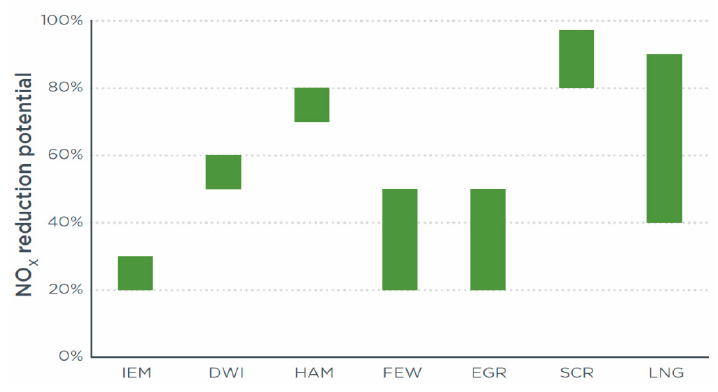
Figure 1. Comparison of NOx reduction technology applied to ship [26].